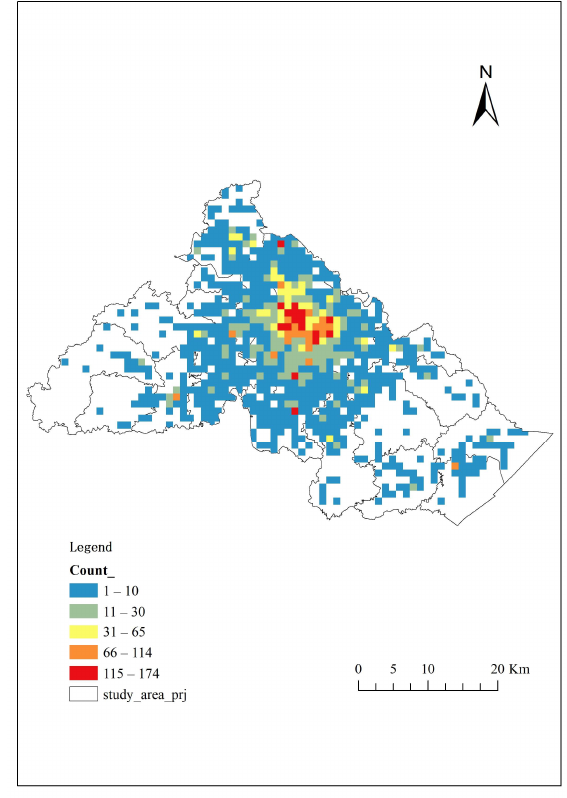
Figure 7. The elderly’s calls amount of demand points.